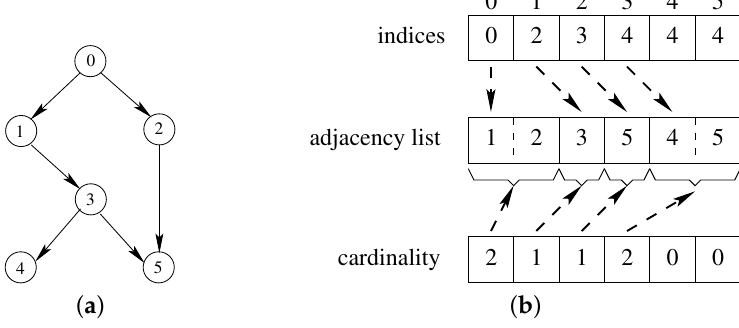
Figure 1. Compressed Sparse Row (CSR) Format: A small example. ( a ) Example graph and ( b ) CSR